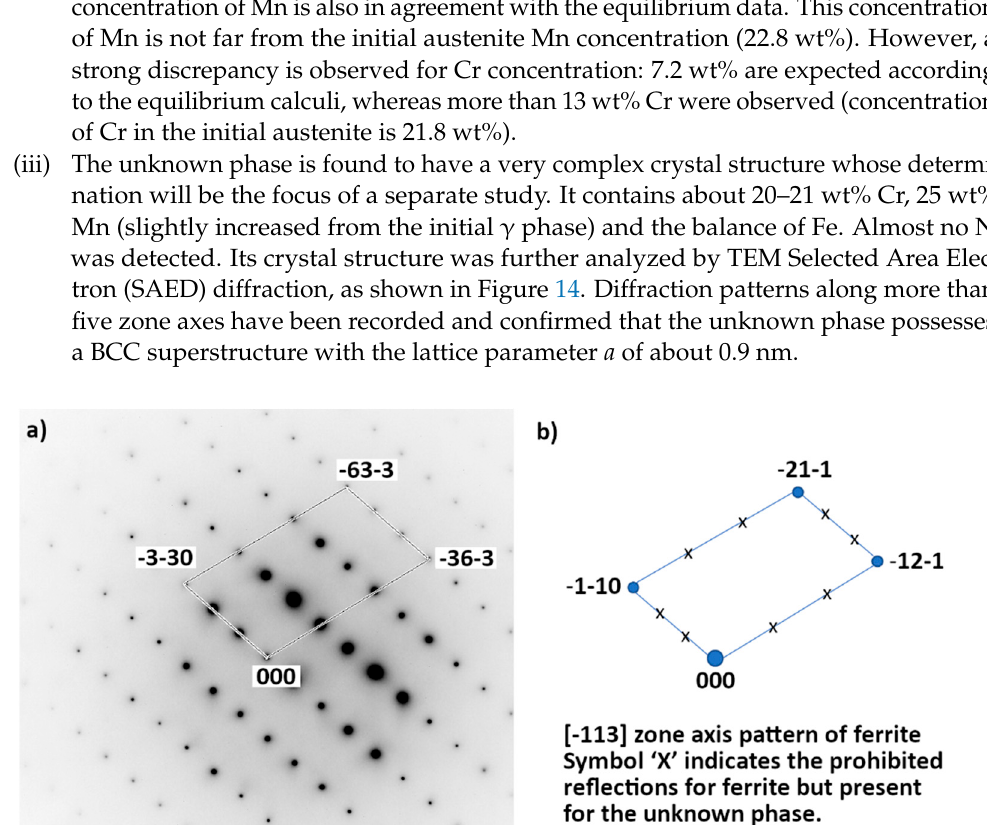
Figure 14. TEM Selected Area Electron Diffraction SAED of the unknown phase in 85%-rolled sam- Figure 14. ( a ) TEM Selected Area Electron Diffraction (SAED) of the unknown phase in 85%-rolled ple after annealing at 575 °C for 978 h. It has a BCC superstructure. Incident beam is parallel to sample after annealing at 575 ◦ C for 978 h. It has a BCC superstructure. Incident beam is parallel to [-113]. [-113]. ( b ) For reference, [-113] zone axis pattern of